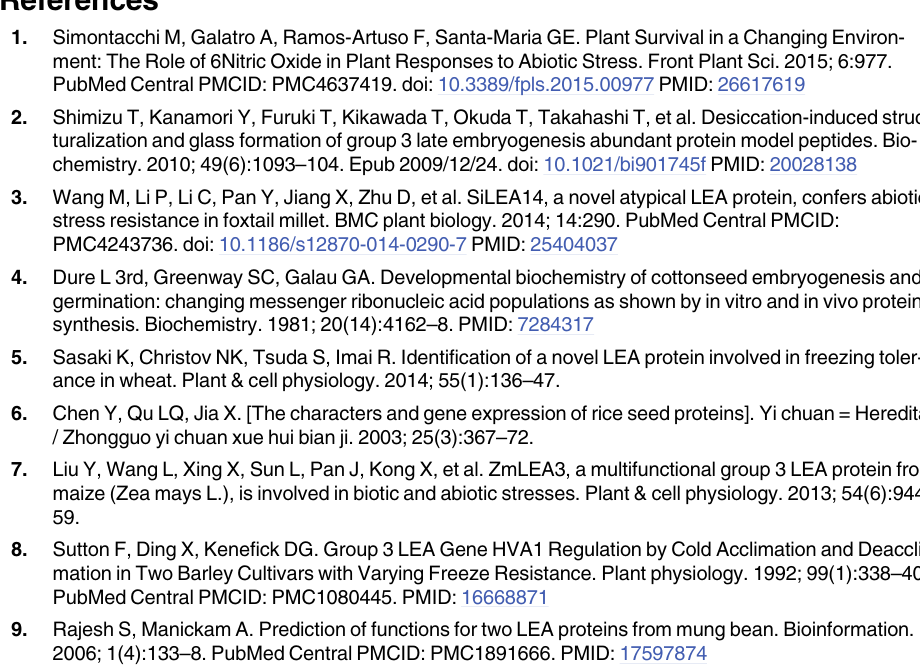
represents the overexpressing WRAB18 induced by IPTG. E . coli harboring only the empty pET28a vector is served as the control, showed in band 2. Band 3 indicates the purified WRAB18. The band M represents the protein marker. (B) The immunodetection result of the expression and purified WRAB18 using anti-His-tag rabbit polyclonal antibody. Lanes 4, 5, 6 represent the immunodetective signal band of empty pET28a control, the overexpressing WRAB18 and the purified WRAB18, respectively. S1 Table. Primers used in this